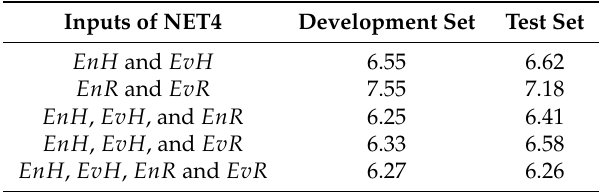
Table 3. The EERs (%) on the development and test sets with different